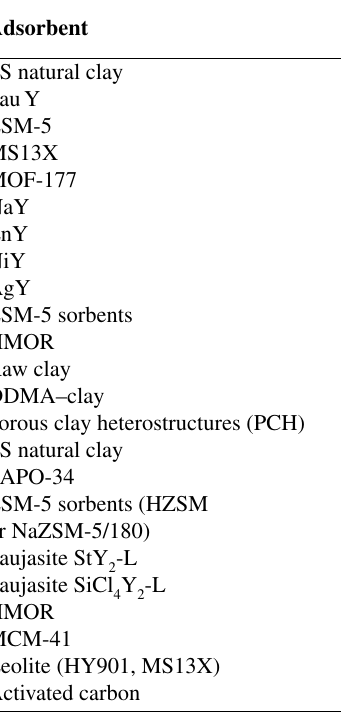
Table 5. Comparison of adsorption capacities toward benzaldehyde (B), methanol (M), or toluene (T) of FS natural clay and some other adsorbents reported in the literature. Adsorbent